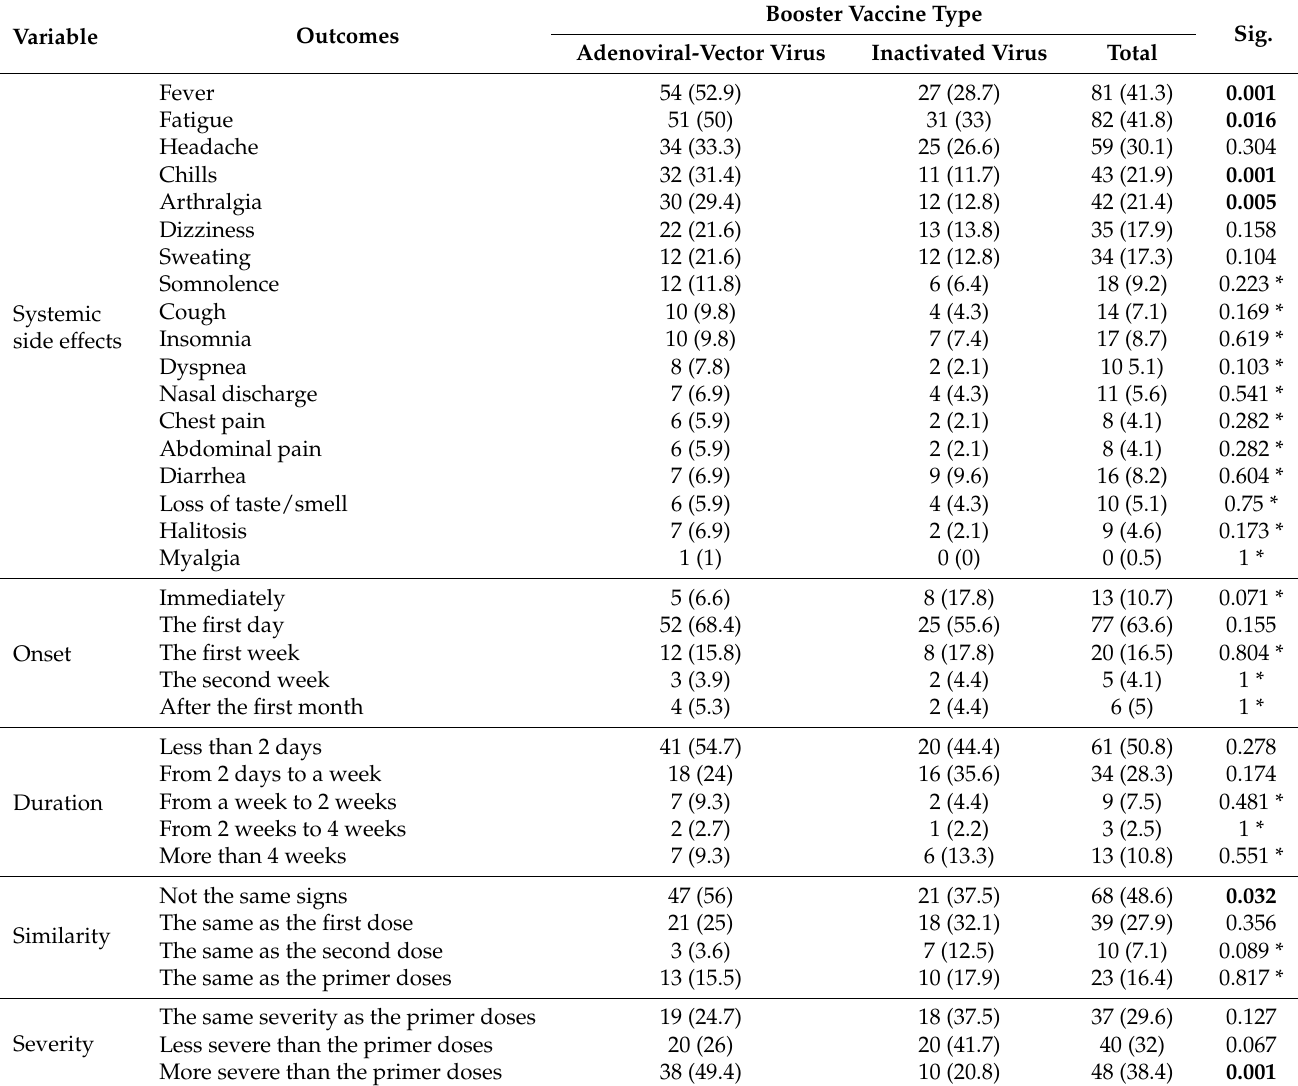
Table 4. Frequency and characteristics of systemic side effects of the Algerian